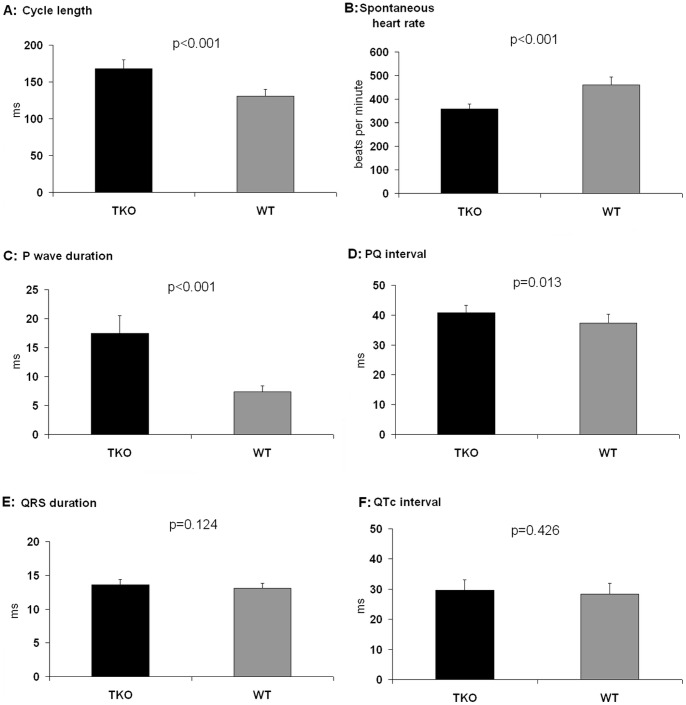
Baseline ECG parameters.Cycle lenghth, spontaneous heart rate, P wave duration and PQ time (A–D) showed a siginificant prolongation in TKO. QRS duration and QTc interval did not differ (E–F). n = 10 for TKO and n = 10 for WT.